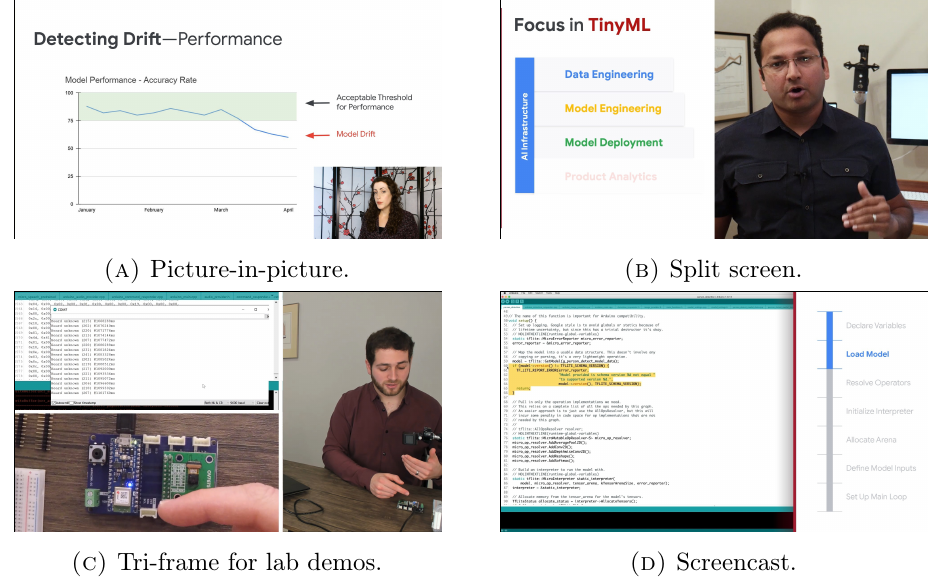
Figure 11. Media Types. We used various video-production strategies throughout the course to maximize learning efficiency. (A) Picture-in-picture places a video clip in a small frame on top of another frame, playing them simultaneously. It enhances the perception of instructor presence while showing the student relevant content. (B) Split-screen, a slight variation, also improves the perception of instructor presence. (C) Tri-frames are useful for lab demos to enable ‘hands-on’ instruction from teaching assistants. (D) Screencasts coupled with associated lecture material reinforce concepts with